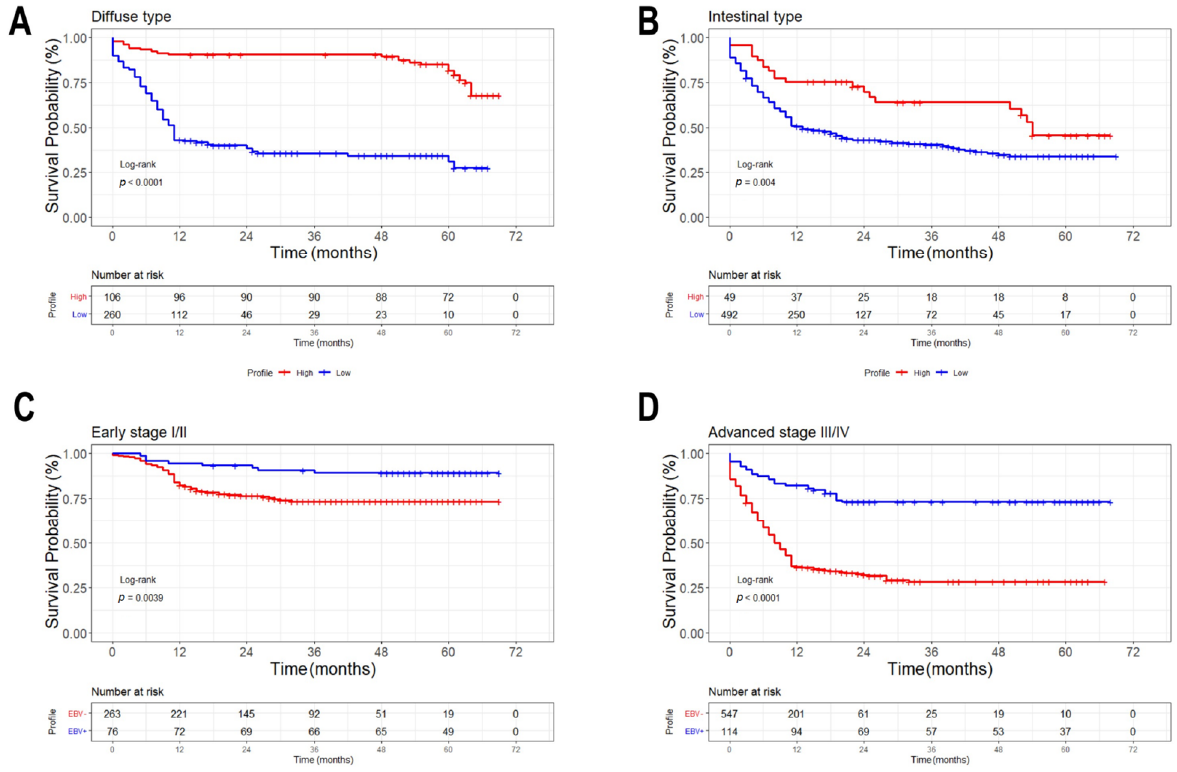
Figure 5. Overall survival (in months) by Kaplan–Meier analysis of the of gastric cancer patients with diffuse and intestinal histological type associated with tumor stage. ( A ) Gastric cancer patients with diffuse histological type that express PD-L1, and ( B ) Gastric cancer patients with intestinal histological type that express PD-L1. We described a high gene expression ( ≥ 1.5; red line), as opposed to low expression (<1.5; blue line) for the association of a lower probability of survival. ( C ) Patients with gastric cancer in stage I/II and ( D ) stage III/IV. The log-rank test with p < 0.05 was used to differentiate the